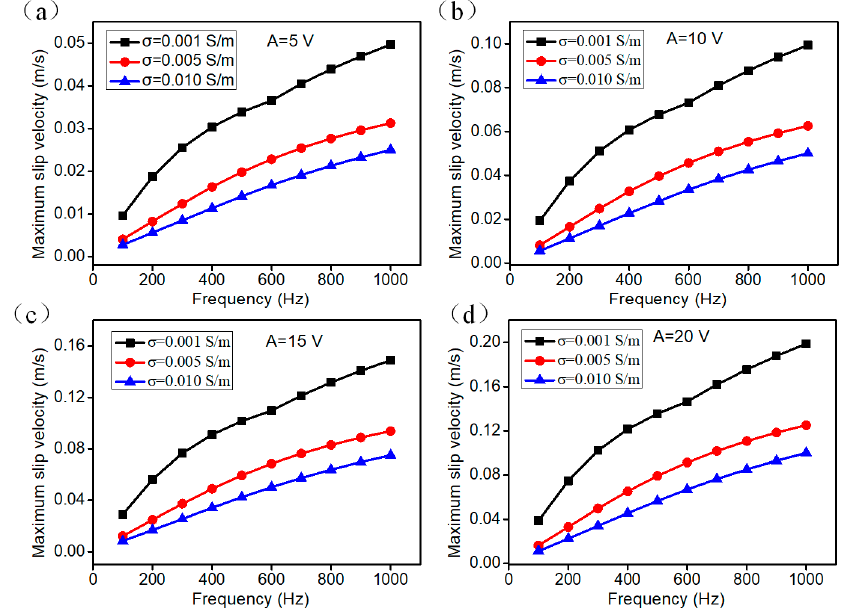
Figure 4. The frequency dependency of maximum slip velocity on the herringbone floating electrode at different voltage input and liquid conductivity. ( a – d ) the maximum slip velocity vs frequency when the voltage intensities are 5 V, 10 V, 15 V and 20 V at the liquid conductivity σ = 0.001 S/m, 0.005 S/m, 0.010 S/m.